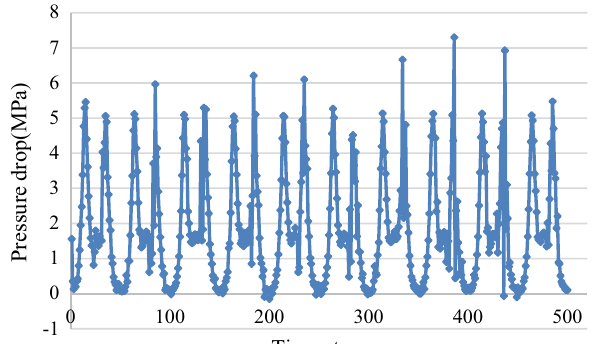
Figure 11. Variation law of pressure drop with time